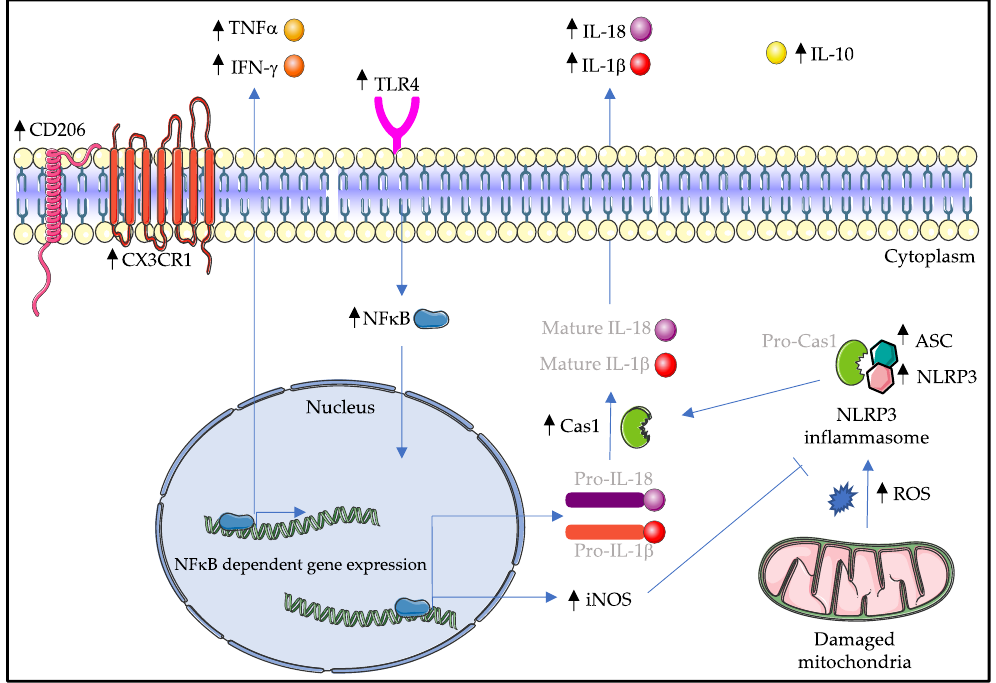
Figure 2. Possible signaling cascades in the spinal cord microglia of the symptomatic SOD1G93A mice. Activation of TLR4 signaling induces the translocation of NF κ B into the nucleus, where NF κ B can upregulate the expression of M1-type proinflammatory cytokines such as TNF α , IFN- γ , iNOS, Pro-IL-1 β and Pro-IL-18. Furthermore, increased production of reactive oxygen species by damaged mitochondria induces the activation of NLRP3 inflammasome, ultimately leading to the cleavage of IL-1 and IL-18 molecules. Surprisingly, M2-type microglia markers IL-10 and CD206 are upregulated. The balance between M1 and M2 activation states is broken down in symptomatic SOD1G93A mice, and M1-type microglia outweigh M2-type microglia, causing microgliosis and eventually motor neuron degeneration. Molecules that are written in light gray are not mentioned in this review. Black arrows indicate an increase in the amount of the respective molecule. CD206: cluster of differentiation 206; CX3CR1: C-X3-C motif chemokine receptor 1; TNF : tumor necrosis factor alpha; IFN- : interferon gamma; TLR4: toll-like receptor 4; IL: interleukin; NF B: nuclear factor kappa B; Cas1: caspase 1; iNOS: inducible nitric oxide synthase; ASC: apoptosis associated speck-like protein containing a CARD; NLRP3: nucleotide binding domain and leucine rich repeat containing protein 3; ROS: reactive oxygen species. 3. C9Orf72 Model A characteristic that accounts for the largest proportion of both familial and sporadic cases of human ALS in Europe is an expansion of a hexanucleotide repeat (GGGGCC) in the 1st intron of C9Orf72 [60,84]. In Europe, approximately 30% of fALS patients and 5% of sALS patients have been identified with expansions in the C9Orf72 gene [60]. Healthy individuals carry 2-22 repeat expansions, whereas ALS patients can have hundreds or thousands of repeats in the C9Orf72 region [85]. Despite being the most common genetic mutation related to ALS, the function of C9Orf72 remains unclear. Several mechanisms have been proposed to describe C9Orf72 -mediated ALS and all of them are not mutually exclusive [86]. Initial studies suggested that C9Orf72 expansion may be a loss-of-function mutation after an approximately 40% reduction in mRNA levels of C9Orf72 was found in the frontal cortex of ALS patients [87]. The second hypothesis is that the transcribed extensions of C9Orf72 form nuclear RNA foci that can sequester RNA-binding proteins and disrupt RNA homeostasis [87]. Finally, the repeat-associated non-ATG (RAN) translation of hexanucleotide repeats can cause aggregation of dipeptide repeat (DPR) proteins (such as poly-GA, -GP, -GR, -PA and -PR), leading to toxicity and cellular dysfunction [88]. So far, it has been challenging to create a suitable genetically modified model with a C9Orf72 -background that resembles human ALS. Knockout mice that exhibited a general or cell-specific loss of C9Orf72 showed no motor or neurodegenerative